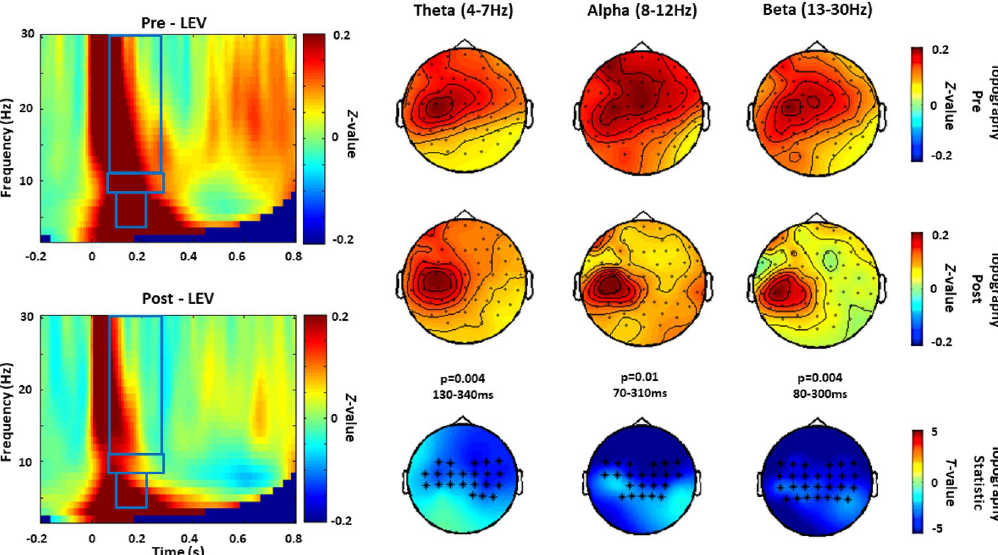
Figure 3. TRSP modulated by Levetiracetam (experiment 1). Grand averages of the time–frequency representation (TFR averaged over ROI channels) of TMS-related oscillations recorded before (pre) and after (post) the intake of Levetiracetam are shown on the left panel. The blue boxes correspond to the time and frequency windows when comparisons between pre and post conditions showed significant drug effects. Topographical distribution of drug-related effects on theta (p = 0.004, 130–340 ms) and alpha (p = 0.01, 70–310 ms) and the beta (p = 0.004, 80–300 ms) band power are reported for pre and post drug conditions on the right panel. Significant electrodes within the bilateral 27 electrode ROIs are represented with asterisks in the t statistic